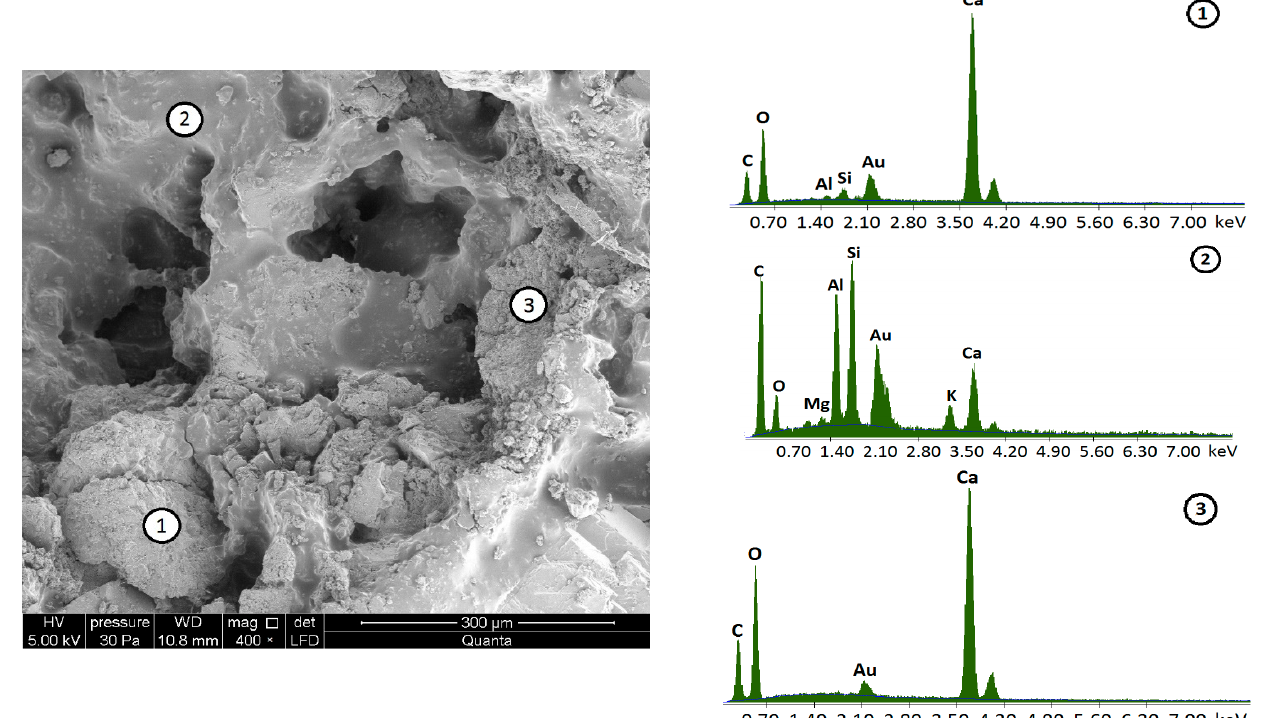
Figure 5. Scanning electron microscope image of the reclaimed asphalt pavement (RAP) using the Quanta Feg 250 SEM and EDS spectrum at measuring points 1–3.